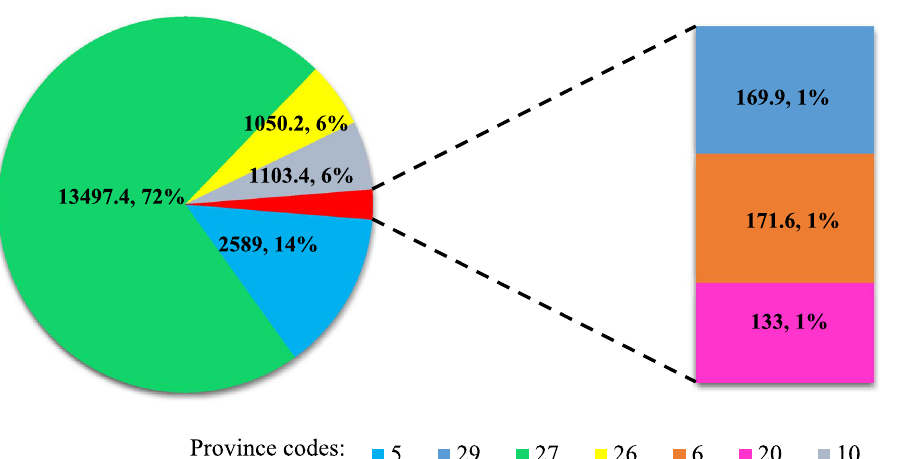
Figure 10. Amount of free land by province. Note The numbers on the map refer to the amount of free land (ha) and the share of total free land